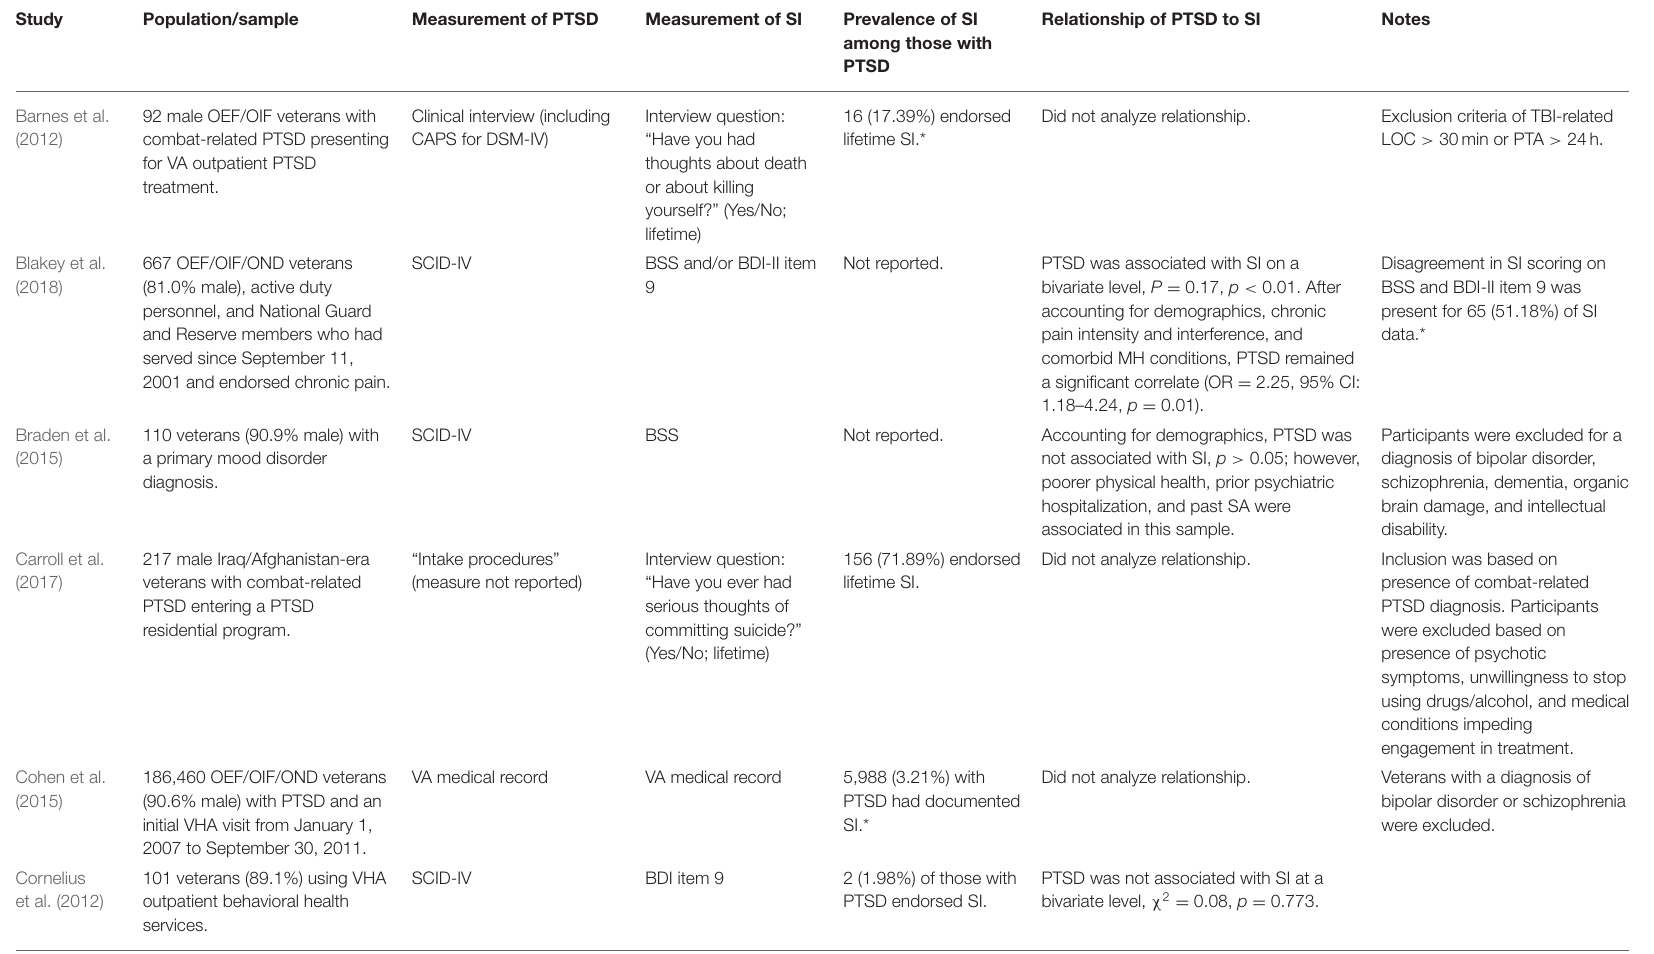
TABLE 2 | SI among military personnel and veterans with PTSD ( n =